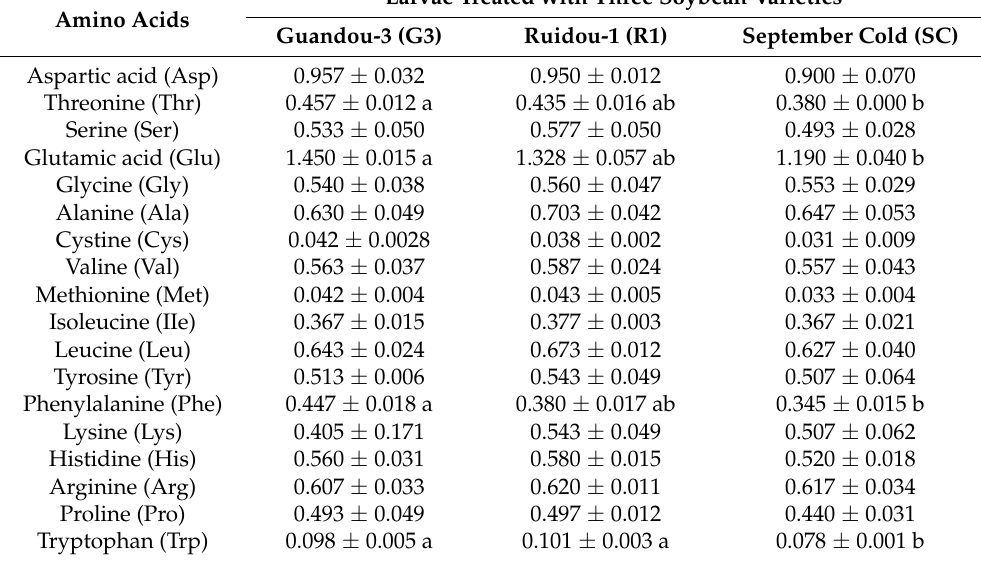
Table 2. The content (g/100 g FW) of amino acids in C. bilineata tsingtauica larvae fed on different soybean cultivars. Amino Acids